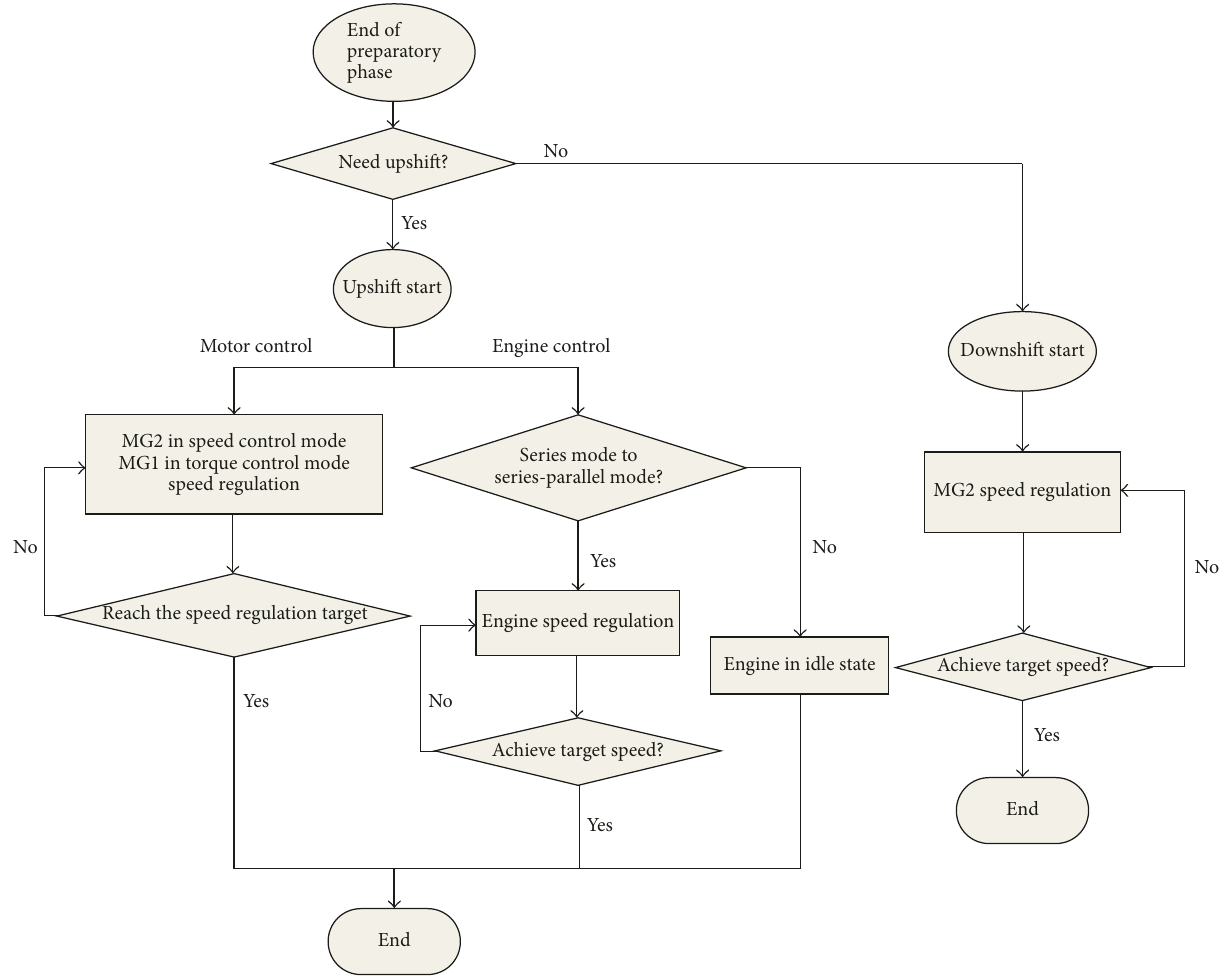
Figure 7: The speed regulation phase’s flow